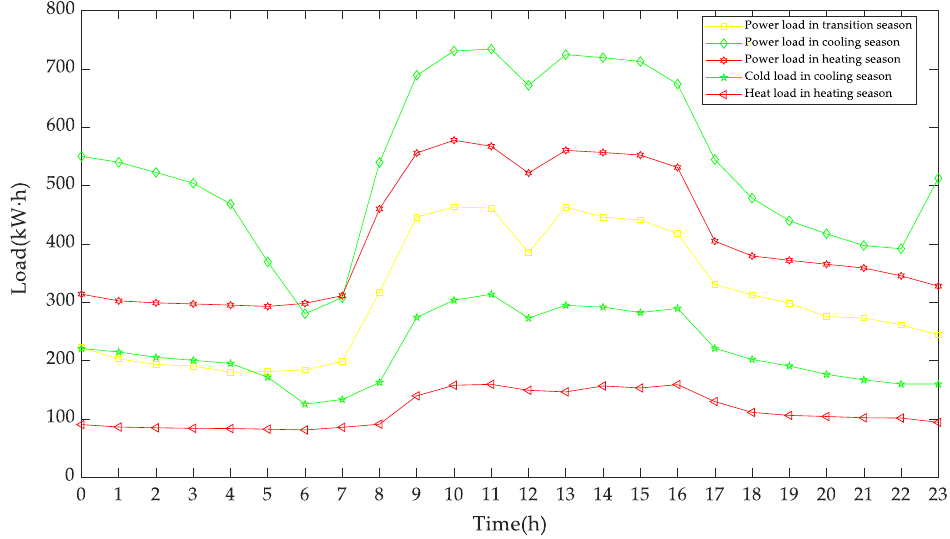
Figure 4. Power load, cooling load, and heating load in a typical day.